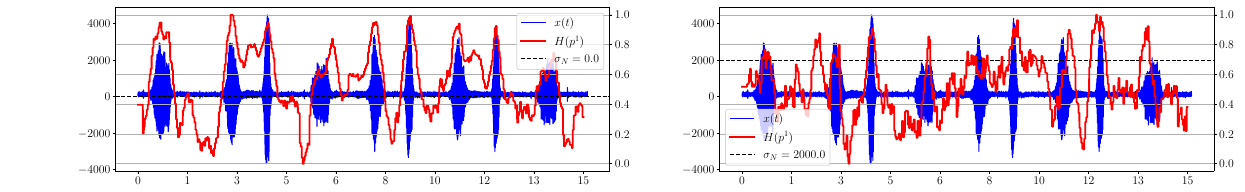
Figure 4. The entropy H ( p 1 ) for the number of letters of the alphabet equal to 8.